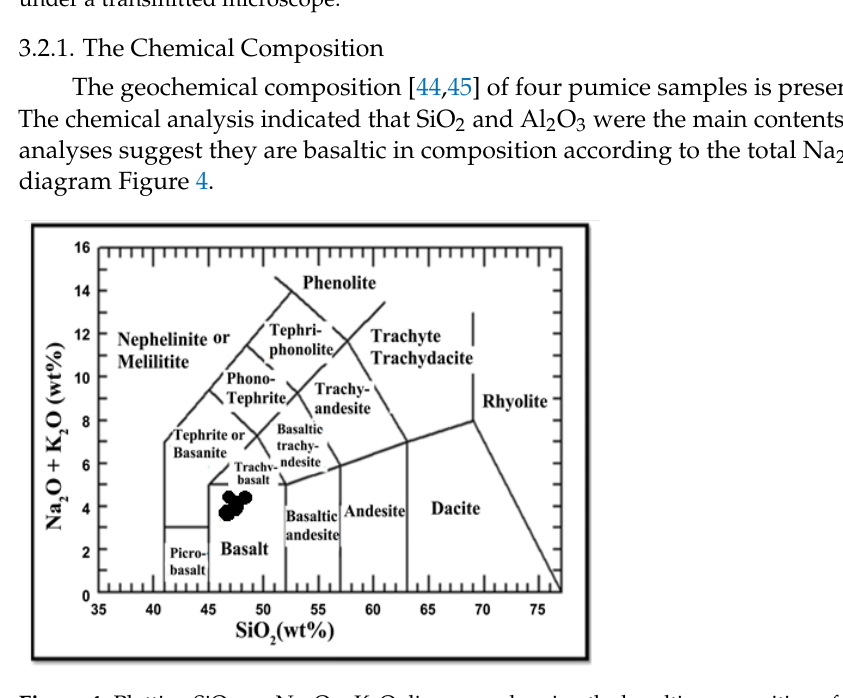
Figure 4. Plotting SiO 2 vs. Na 2 O + K 2 O diagrams, showing the basaltic composition of pumice